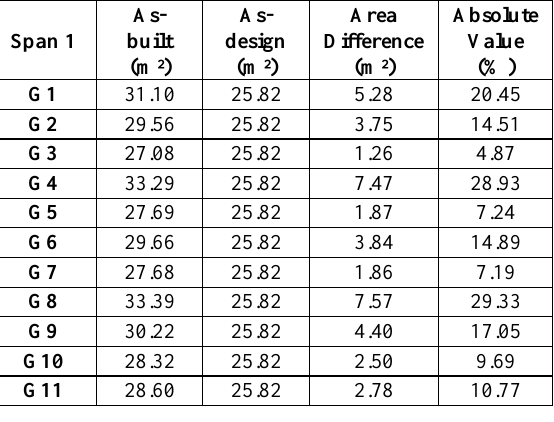
Table 3. Results for eleven girders in Span 1.